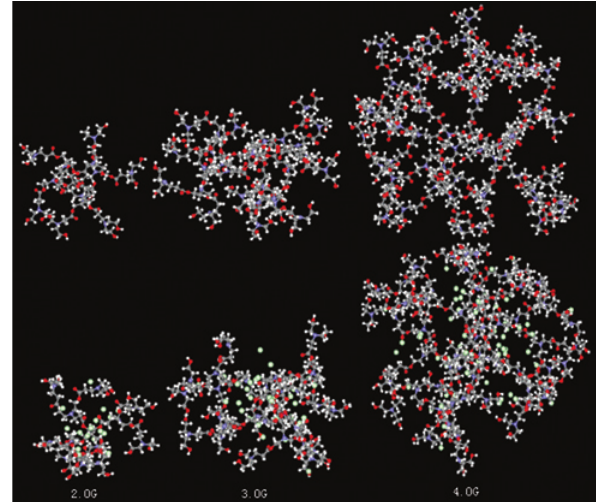
Figure 4 Topological structure of G2, G3, and G4